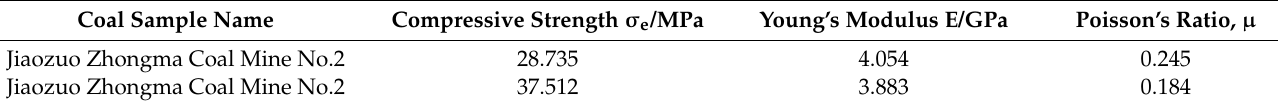
Table 5. Basic mechanical parameters of